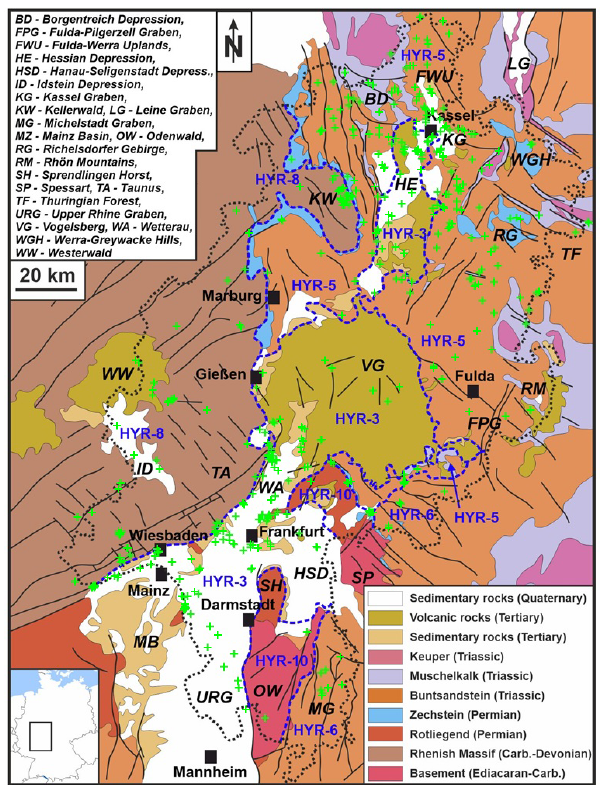
Figure 1. Hydrochemical sampling points (green crosses) and hy- drochemical regions in the federal state of Hesse. Generalized geo- logical map after Schäffer et al.